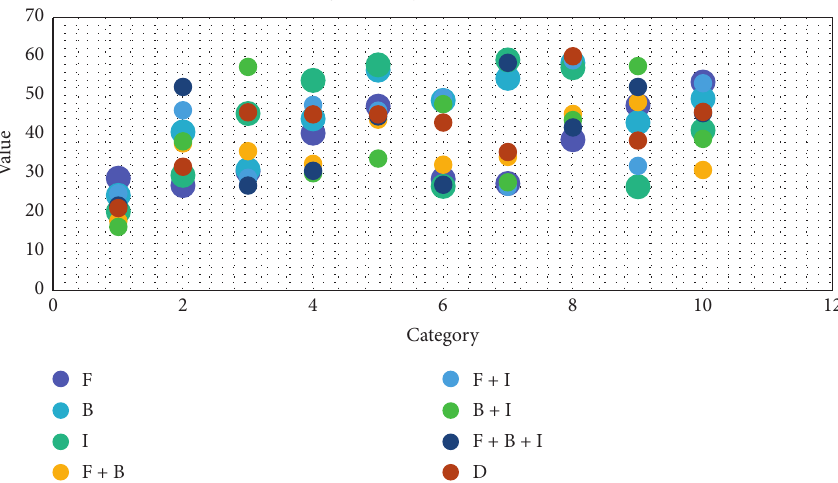
Figure 6: Average accuracy of discrete dimensions.